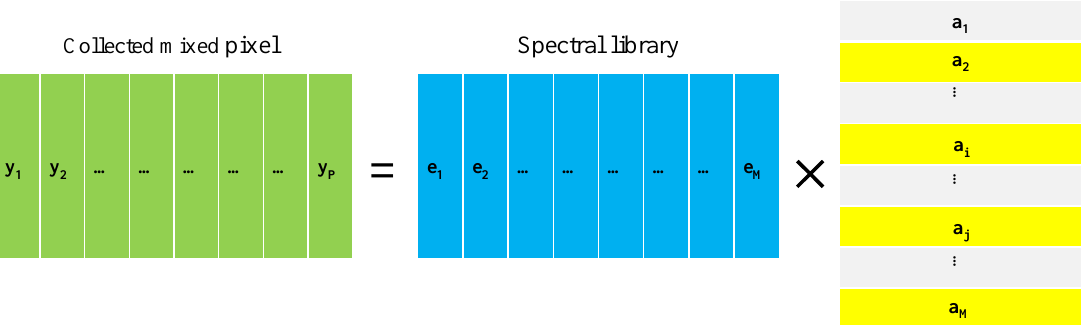
Figure 3. Graphical illustration of the collaborative sparse unmixing method through variable splitting and augmented Lagrangian